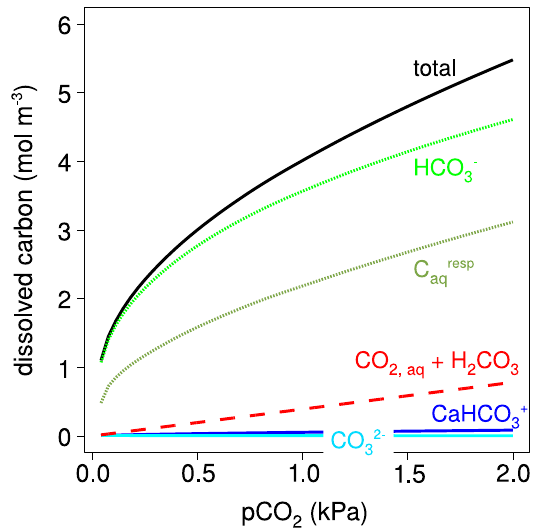
Fig. 2. Molar carbon concentrations of the different dissolved carbon species in a “ H 2 O - CO 2 - CaCO 3 ”- system (system c) as a function of the CO 2 partial pressure for T = 293 K . C resp aq is the sum of all dissolved carbon species that originate from respiration.